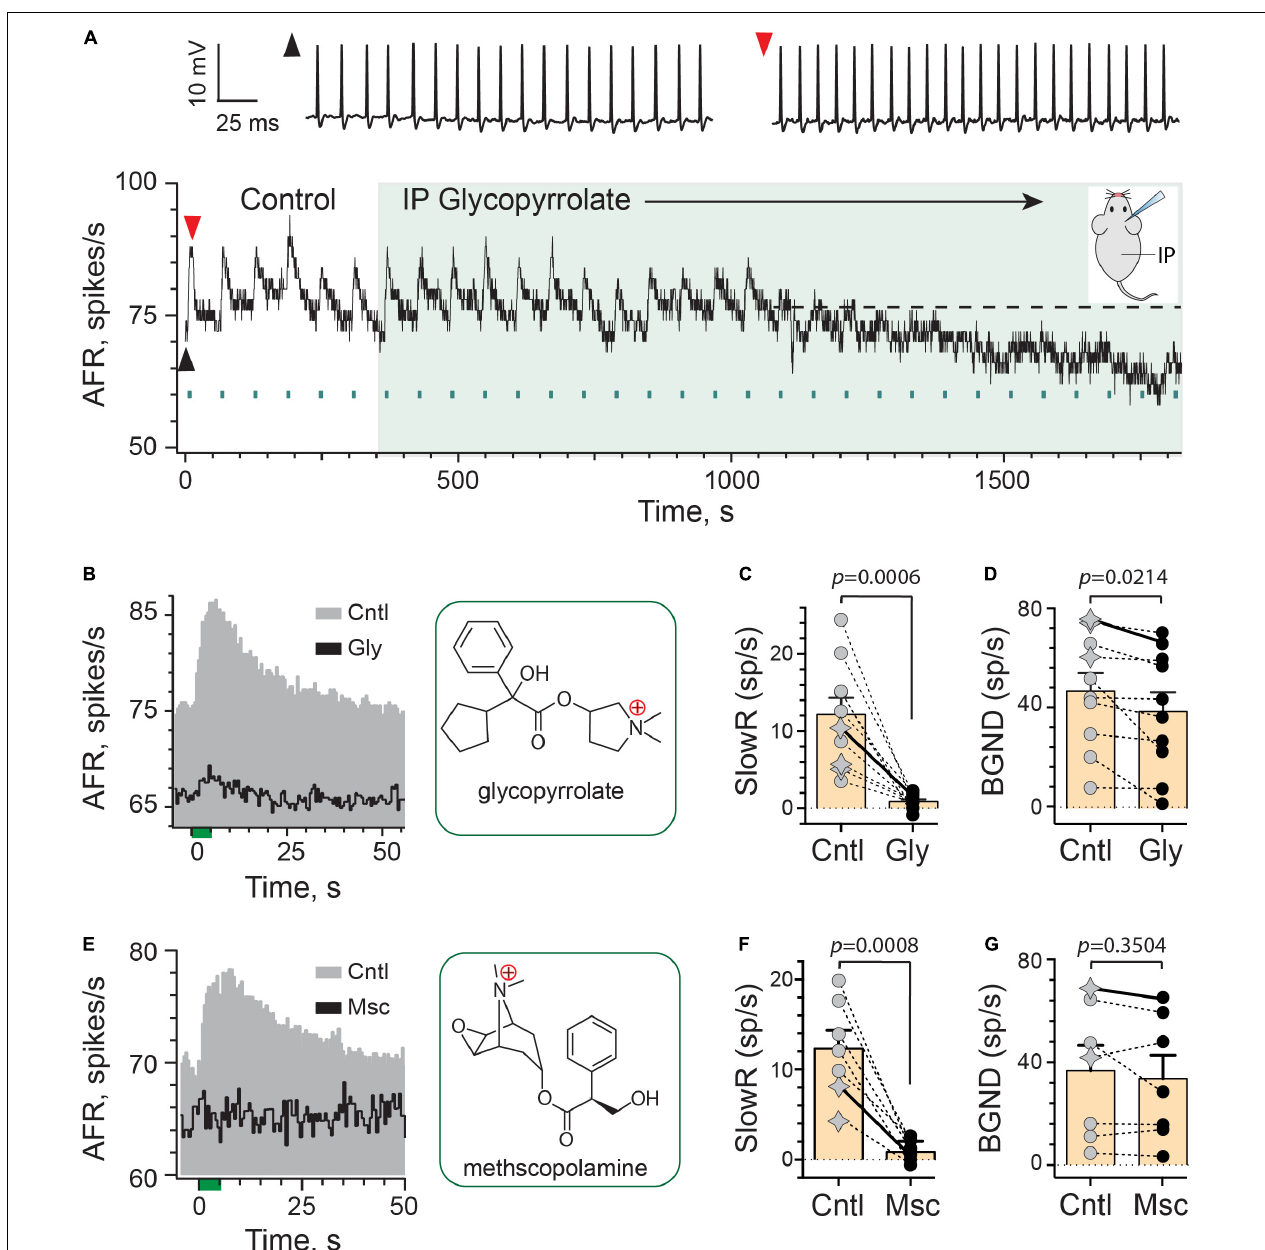
FIGURE 2 | Efferent-mediated slow excitation of vestibular afferents is antagonized by peripheral mAChR antagonists. (A) Continuous response histogram from a regular afferent shows changes in afferent firing rate (AFR) during midline efferent stimulation (green bars, 333/s for 5 s every 60 s) before and after administering glycopyrrolate (IP, 2 mg/kg) at t = 360 s (green box). Raw spike data from baseline (black arrowhead) and peak efferent-mediated slow excitation (red arrowhead) are shown above the histogram. Inset: mouse diagram – afferent recording from right ear during IP drug delivery. (B) Corresponding average response histograms from the same afferent in (A) were generated separately for 6 efferent shock trains during control conditions (Cntl) and 10 trials starting at t = 1,150 s during IP glycopyrrolate (Gly). Chemical structure for glycopyrrolate is shown in green box. (C,D) Mean peak slow excitation (SlowR) and background discharge rates (BGND) are plotted for 10 afferents from 10 animals before (Cntl, gray) and after IP glycopyrrolate (Gly, black). Star symbols and filled circles in control column indicate regular and irregular afferents, respectively. Orange bars with error bars reflect the population mean and SEM. Solid line shows values from histograms in (B) . Indicated p -values from paired t -test. (E) Average response histograms showing the effects of midline efferent stimulation in an irregular afferent before (Cntl, gray) and after IP administration of 2 mg/kg methscopolamine (Msc, black). Chemical structure for methscopolamine is shown in green box. (F,G) Mean peak slow excitation (SlowR) and background discharge rates (BGND) are plotted for seven afferents from seven animals before (Cntl, gray) and after IP methscopolamine (Msc, black). Orange bars with error bars reflect the population mean and SEM. Solid line shows values from histograms in (E) . Indicated p -values from paired t -test. Binning in (A,B,E) is 500